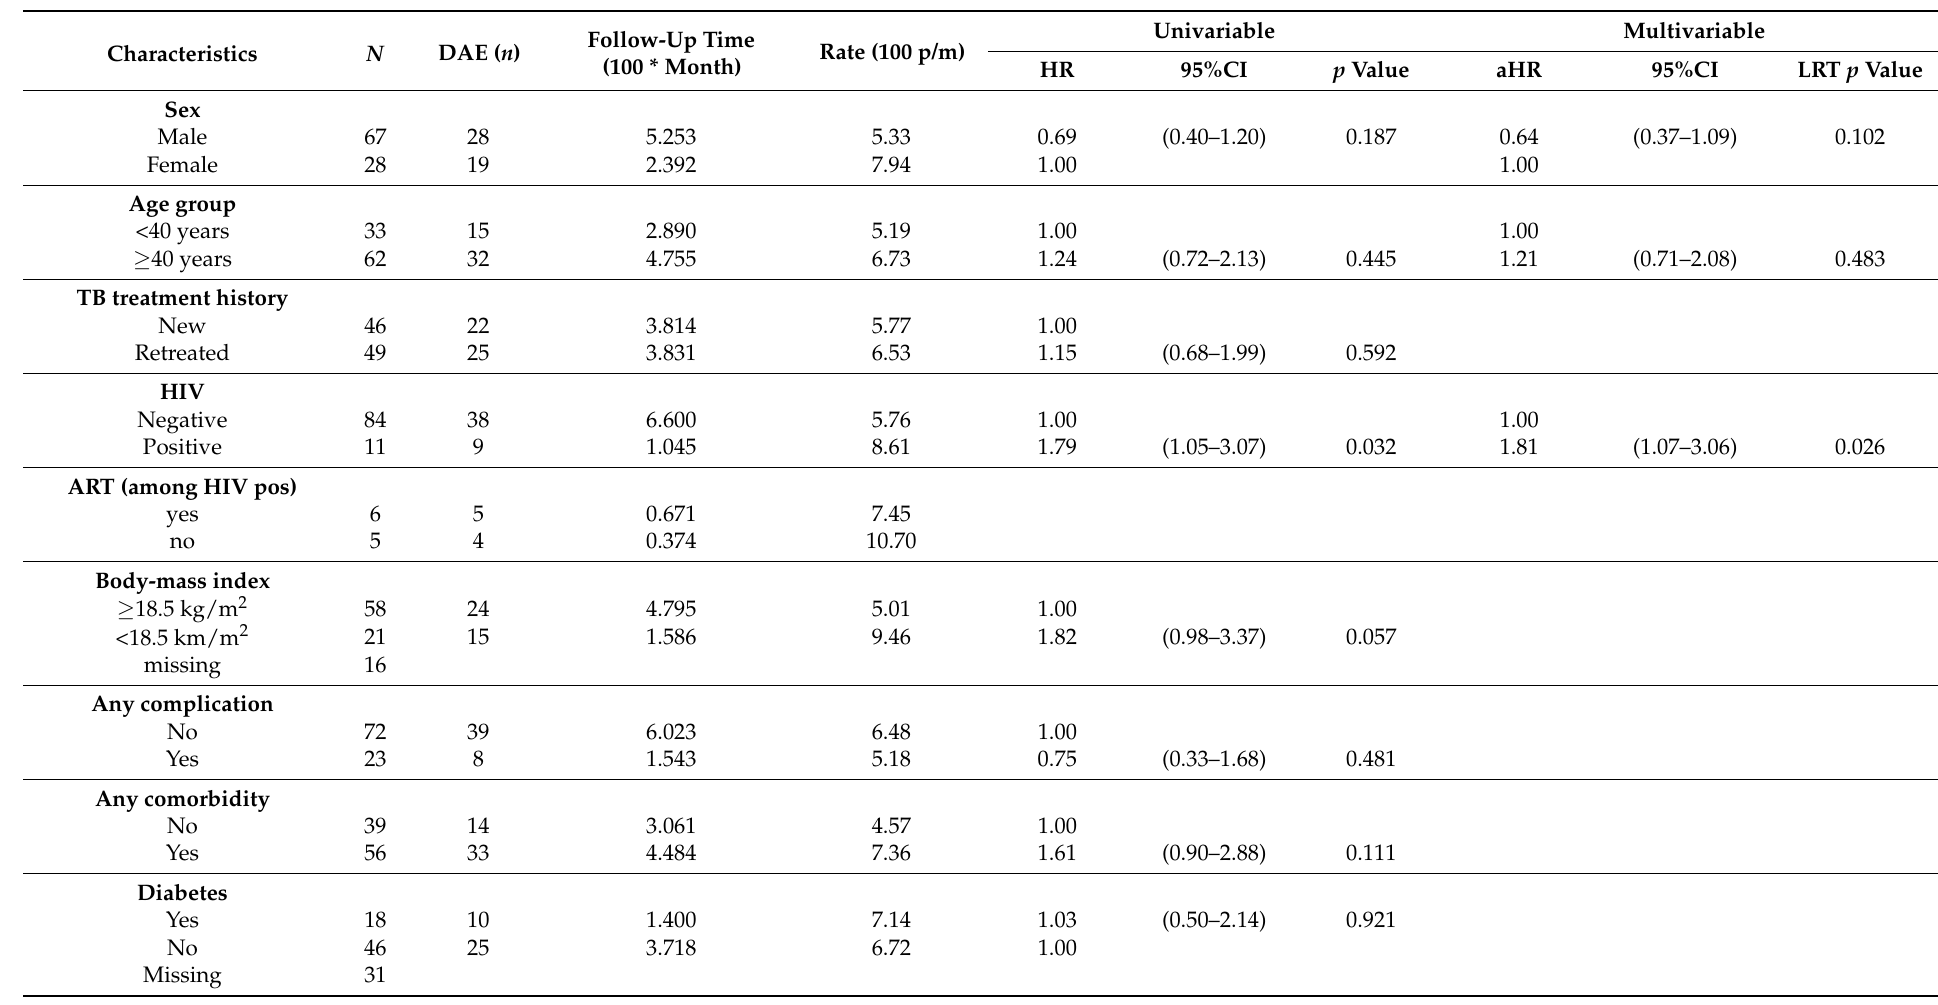
Table 5. Results of Andersen–Gill Cox regression of the patients factor associated with time to adverse event among 95 RR-TB patients receiving a short course treatment regimen in Tashkent, Uzbekistan